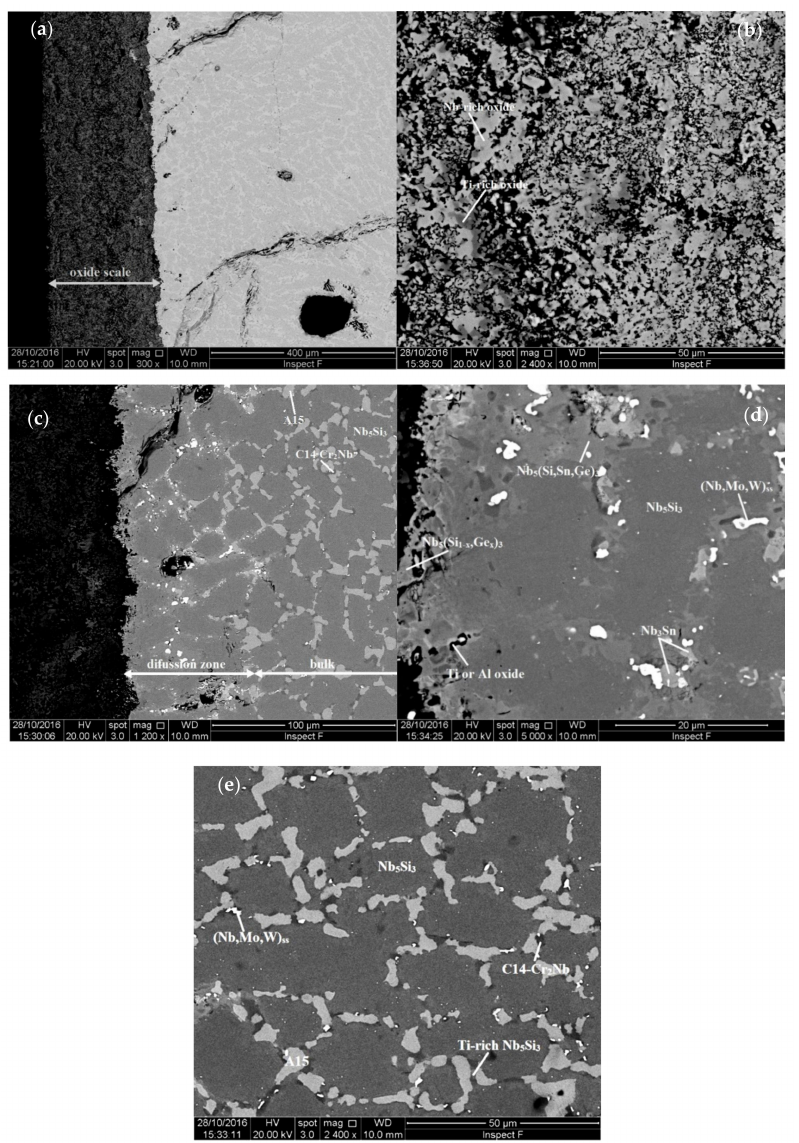
Figure 5. BSE images of the microstructure of a cross section of the oxidised alloy JZ4 at 1200 ◦ C, ( a ) oxide scale and microstructure below it, ( b ) oxide scale, ( c ) di ff usion zone and bulk, ( d ) microstructure of the di ff usion zone and ( e ) bulk